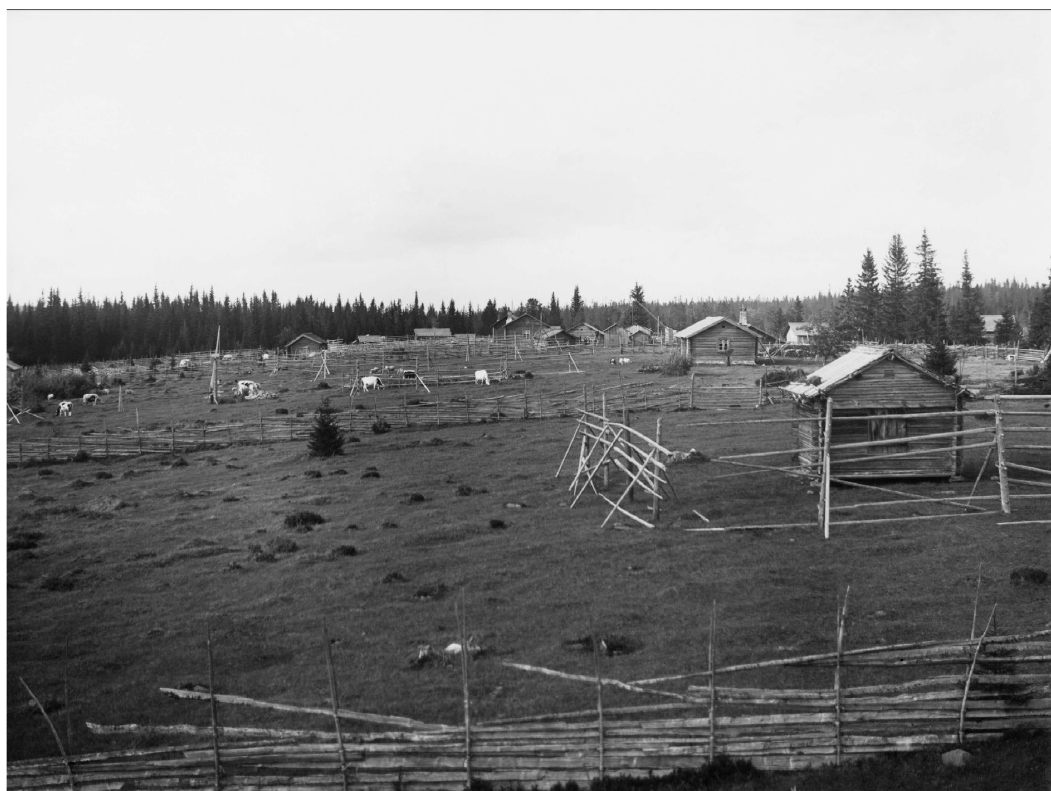
Figure 6. Pasture at the shieling Rismyren, Lima parish, Dalecarlia, in the early twentieth century (Photo Georg Renström, Courtesy: The Nordic Museum, Stockholm, NMA.0038914).